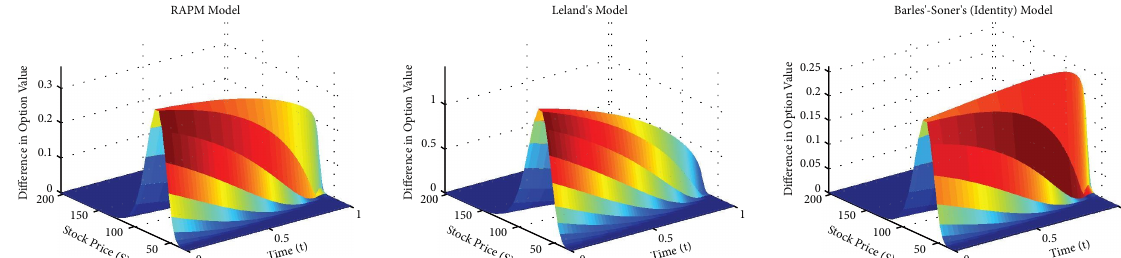
Figure 6: Here, we illustrate | V and L stands for linear model.